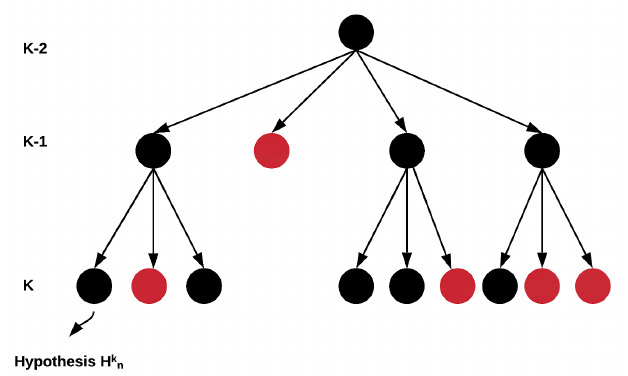
Figure 2. Tree representation of the formed multiple hypotheses. Black dot represents a hypothesis, and a red dot represents a hypothesis that